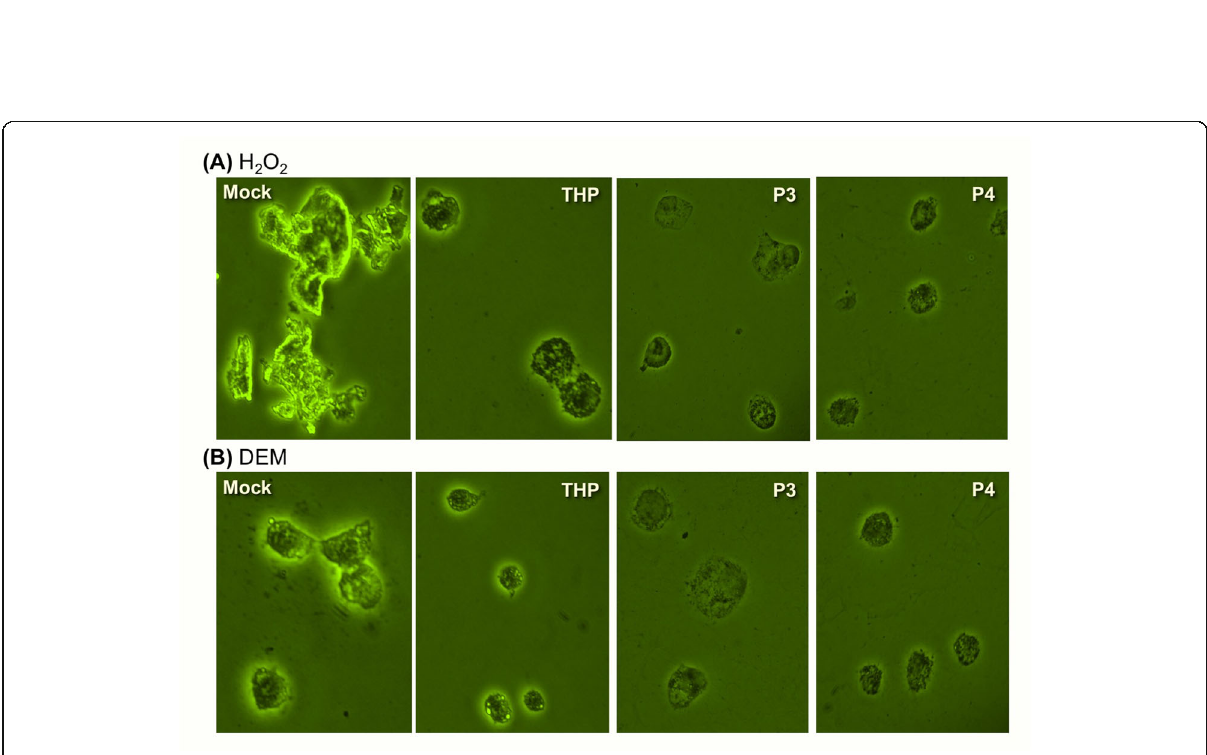
Fig. 5 Fluorescent ex vivo imaging of ROS in HCT-116 cells oxidized with H 2 O 2 or DEM. Cells (10 5 cells/L) were treated as in Fig. 4 and fixed with 2% paraformaldehyde in PBS and observed with Keyence BZ-9000 fluorescence microscope under antifade reagent. The non-fluorescent DCFH- DA is oxidized by ROS into DCF, which irradiates green/yellow fluorescence into and around the stressed